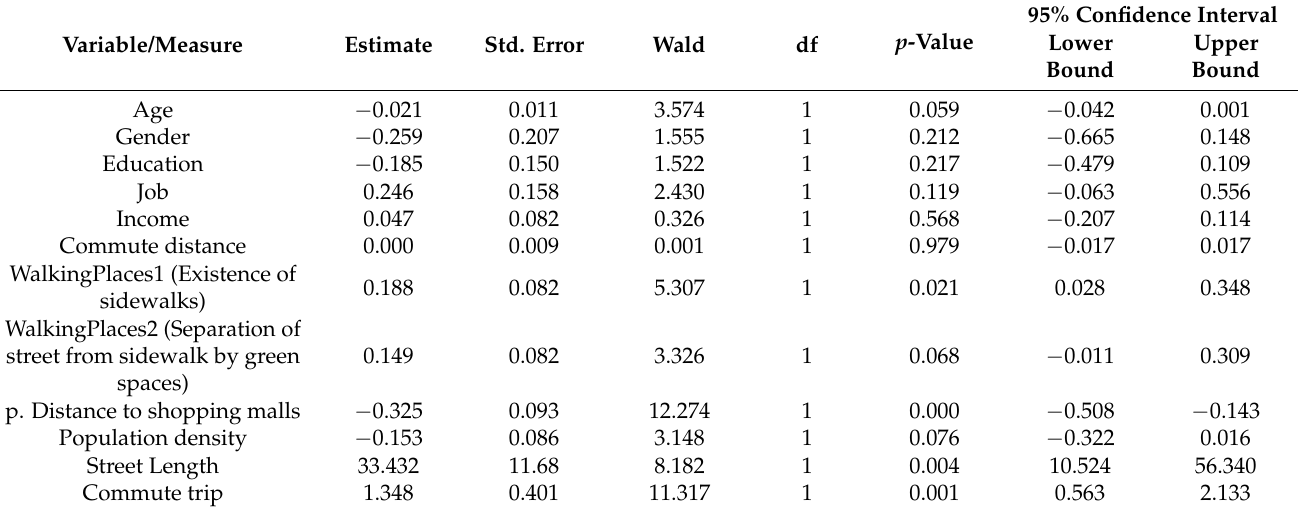
Table 4. Model for the relationship between active lifestyle and feeling